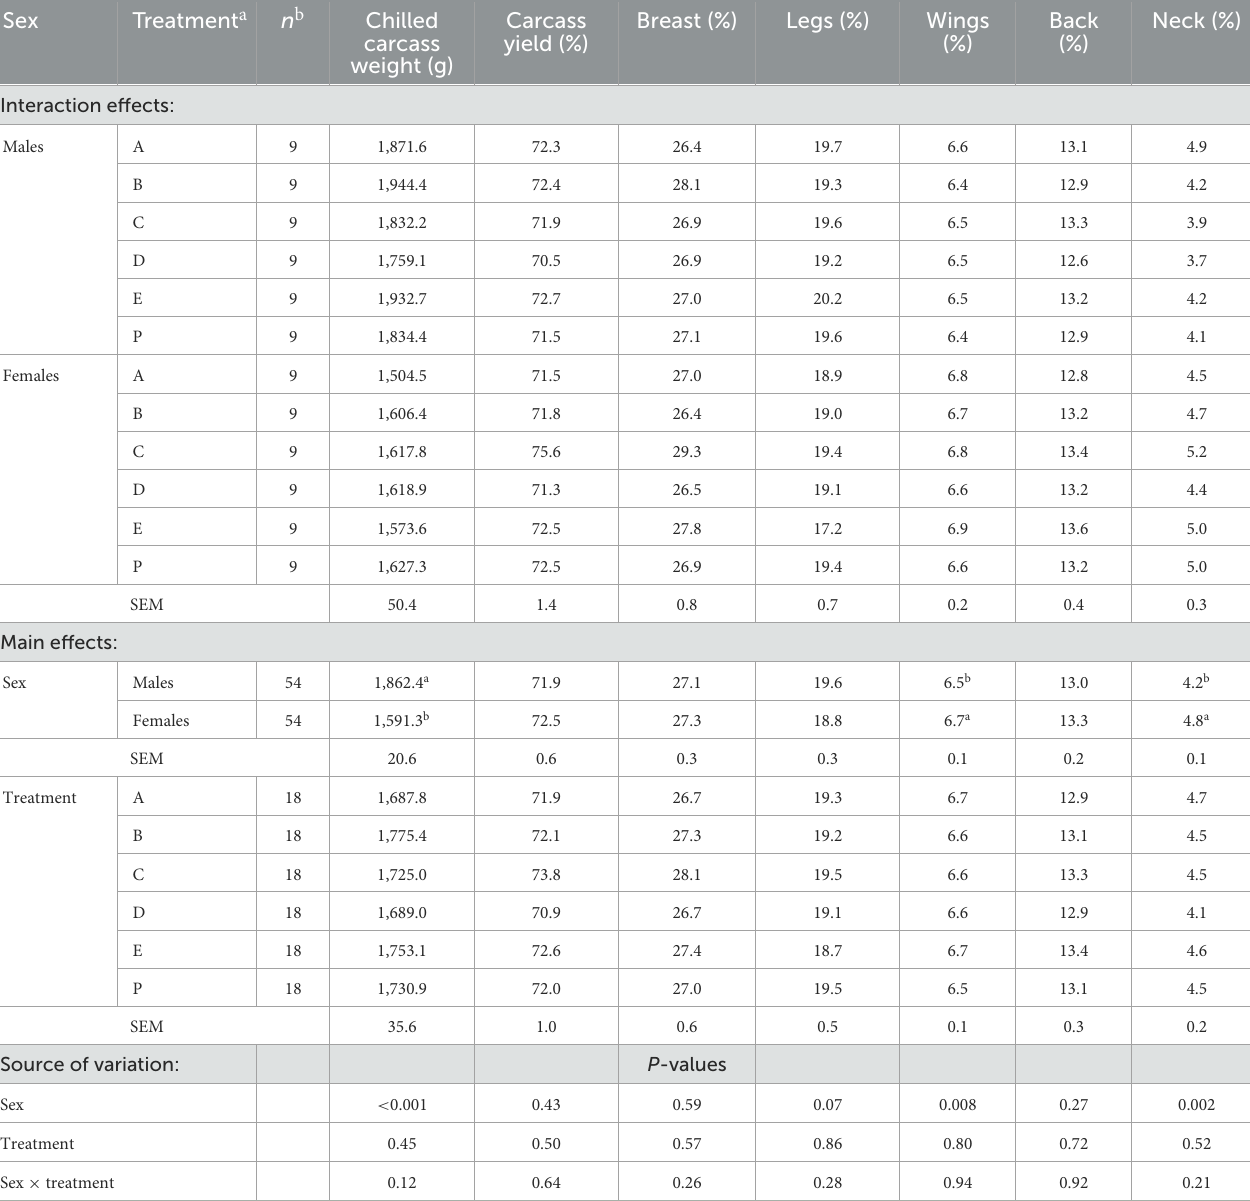
TABLE 7 Effects of adding nano-emulsified plant oil and probiotics to drinking water during different periods besides sex on processing performance of broiler chickens at 35 days of